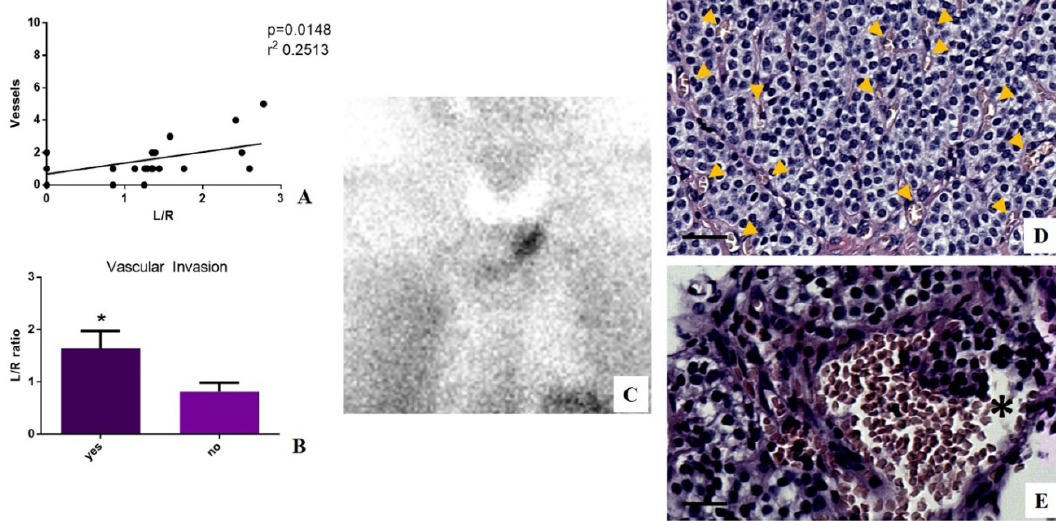
Figure 3. Evaluation of sestamibi uptake, angiogenesis, and vascular invasion in patients affected by hyperparathyroidism. ( A ) Graph shows linear regression analysis between the number of vessels and L / N ratio. ( B ) Graph displays a significant increase in sestamibi uptake in parathyroid lesions showing vascular invasion (yes) as compared to lesions without vascular invasion (no) (* p = 0.0377). ( C ) Image shows [ 99 mTc]Sestamibi uptake in a 61-year-old man with primary hyperparathyroidism. A parathyroid carcinoma (0.7 cm) was identified after the surgery by histological analysis. ( D ) Image displays numerous vessels (yellow arrows) in a tumor area. ( E ) Image shows a large vessel with several cancer cells (asterisk). Scale bar represents 100 μm in all images.